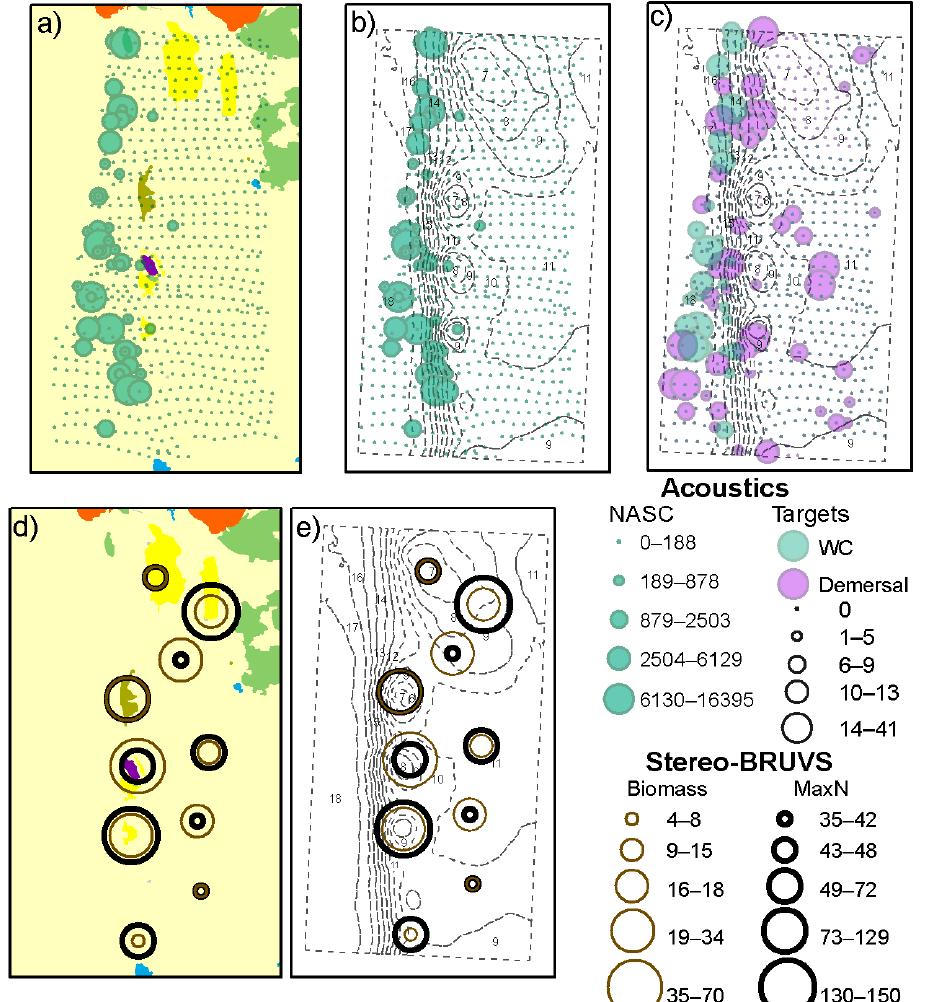
Figure 3. ( a ) Depth-stratified acoustic NASC showed as graduated circles laid over the benthic habitats following the classification specified in Figure 1. ( b ) Depth-stratified acoustic NASC showed as graduated circles with isobaths shown in the background. ( c ) Total number of acoustic targets in the water column (green) and in the demersal layer (purple) shown as graduated circles with isobaths shown as discontinuous lines. ( d ) Relative biomass and abundance (MaxN) from the stereo-BRUVs shown as graduated circles laid over the benthic habitat map. ( e ) Relative biomass and abundance (MaxN) from the stereo-BRUVs shown as graduated circles with the isobaths shown as discontinuous lines. Table 2. Summary of the main variables measured in Cockburn Sound and Ningaloo Marine Park, including acoustic NASC and relative biomass (kg) and abundance (MaxN) from the